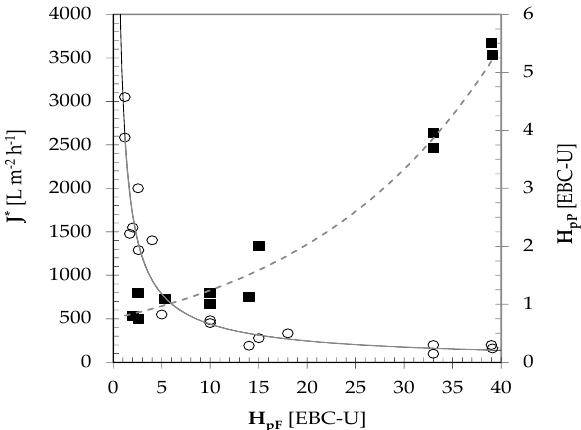
Figure 2. Effect of rough beer turbidity (H pF ) on the limiting permeation flux (J * : ) and turbidity (H pP : (cid:4) ) of the permeate collected from the CFMF plant operating as reported in the text. The continuous and broken lines represent the least square regression lines.